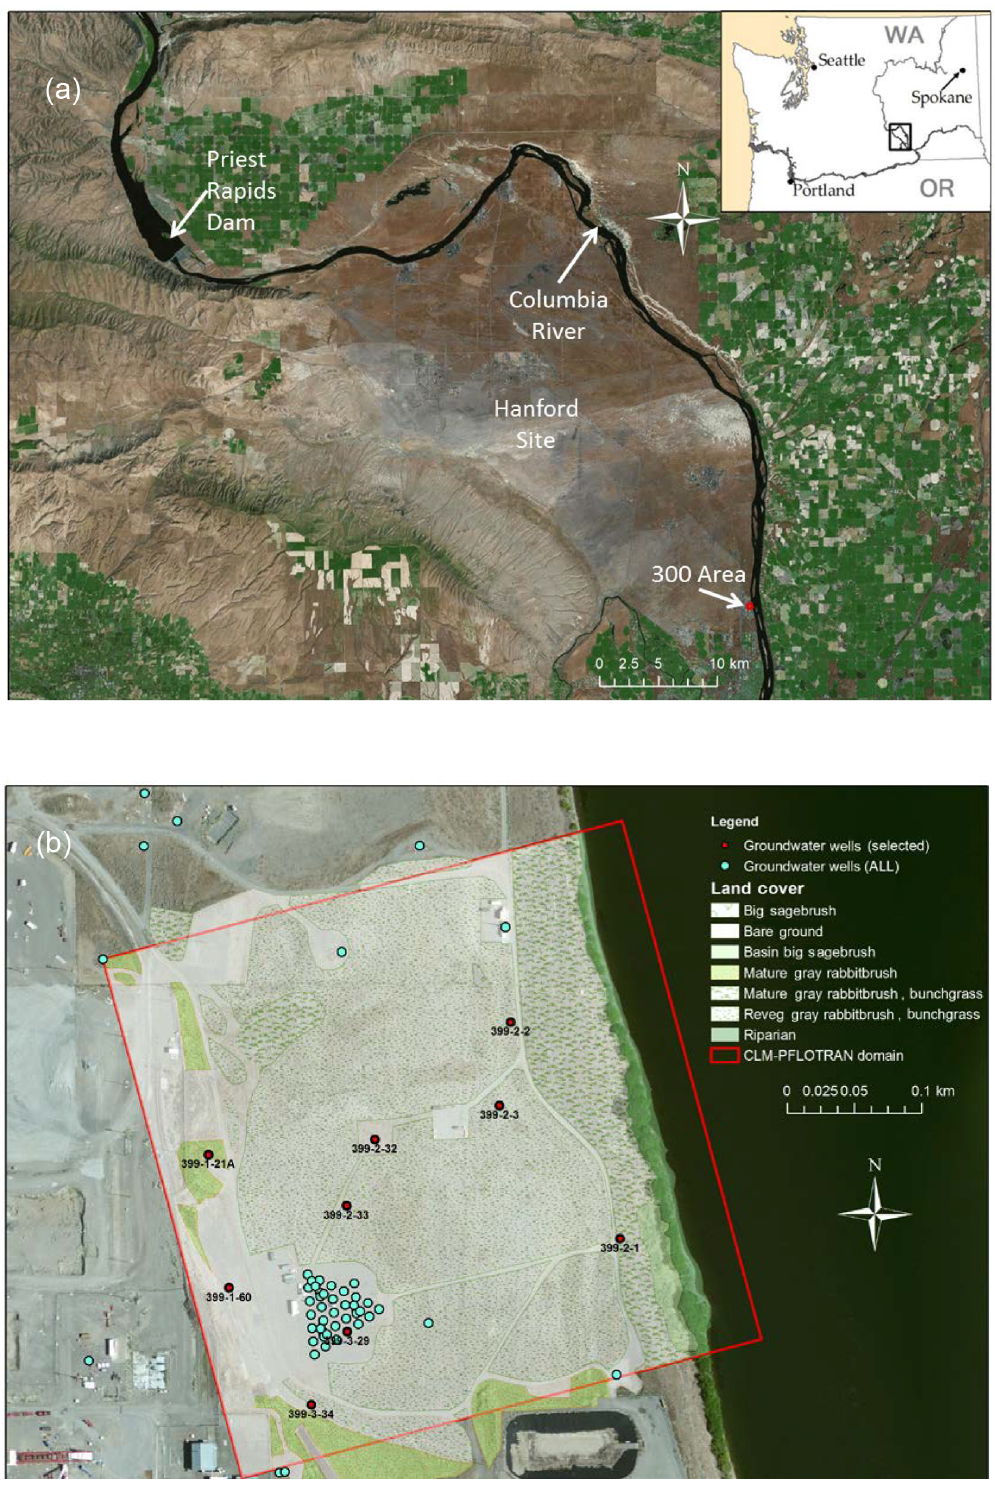
Figure 3. (a) The Hanford Reach of the Columbia River and the Hanford Site location in south-central Washington State, USA; (b) the 400m × 400m modeling domain located in the Hanford 300